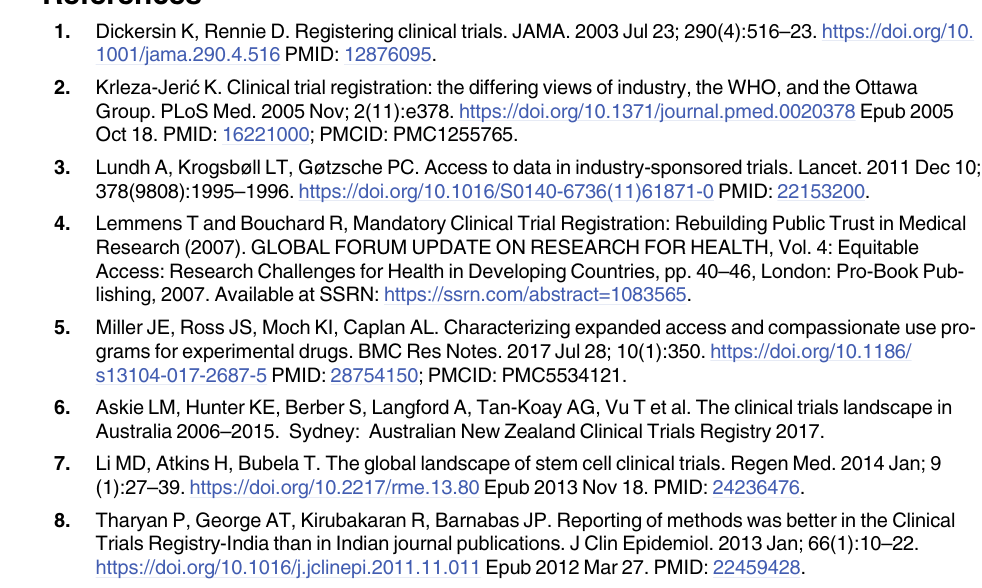
S4 Table. For each registry, a listing of the Extra fields in the Brief and Detailed views. S5 Table. Data on multiple aspects of each registry. (a) whether the PI name is